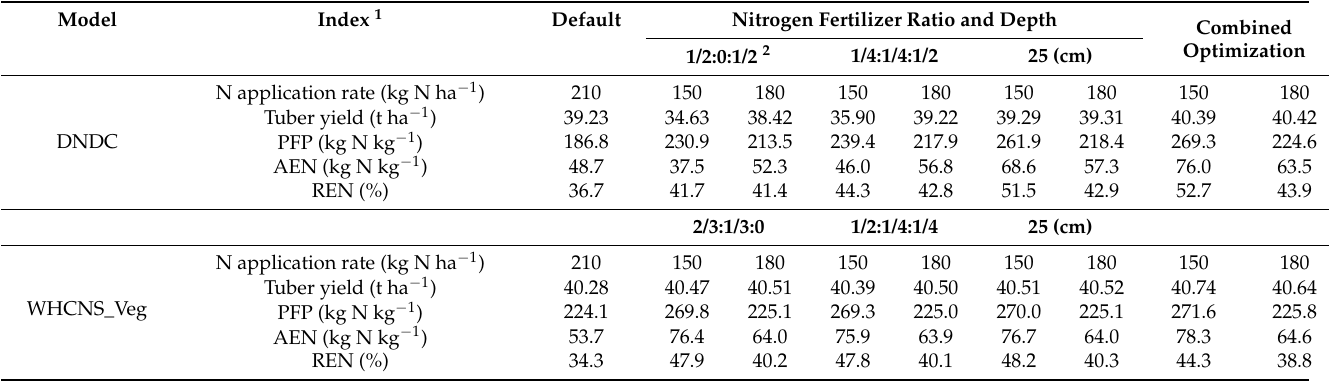
Table 7. Recommendations of field management practices based on the sensitivity analyses using the DNDC and WHCNS_Veg models in Wuchuan, China.